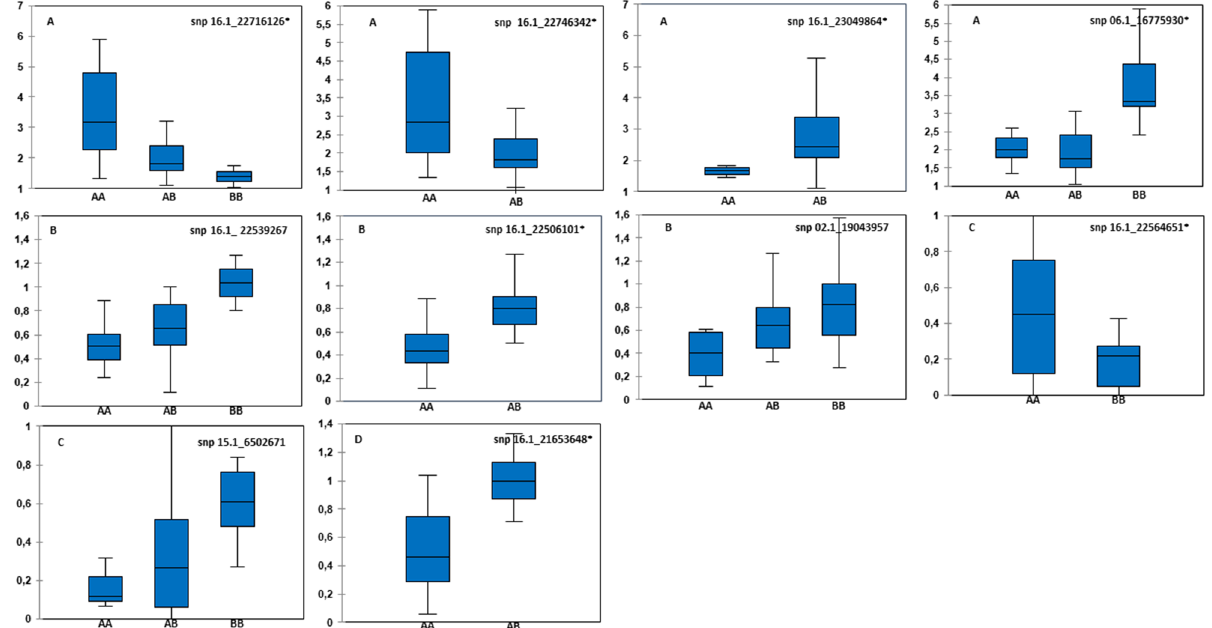
Figure 4. Box plots of the distribution of phenotypic data in the validation panel according to the observed genotypic classes. ( A ) Alleles controlling the ratio length/width, ( B ) Alleles controlling shape regularity, ( C ) Alleles controlling skin texture, ( D ) Alleles controlling tubercular roots. The letter A refers to the reference allele (when calling for variants on the D. rotundata genome) and B to the alternate allele. *The observed genotypic classes were significant different at p <